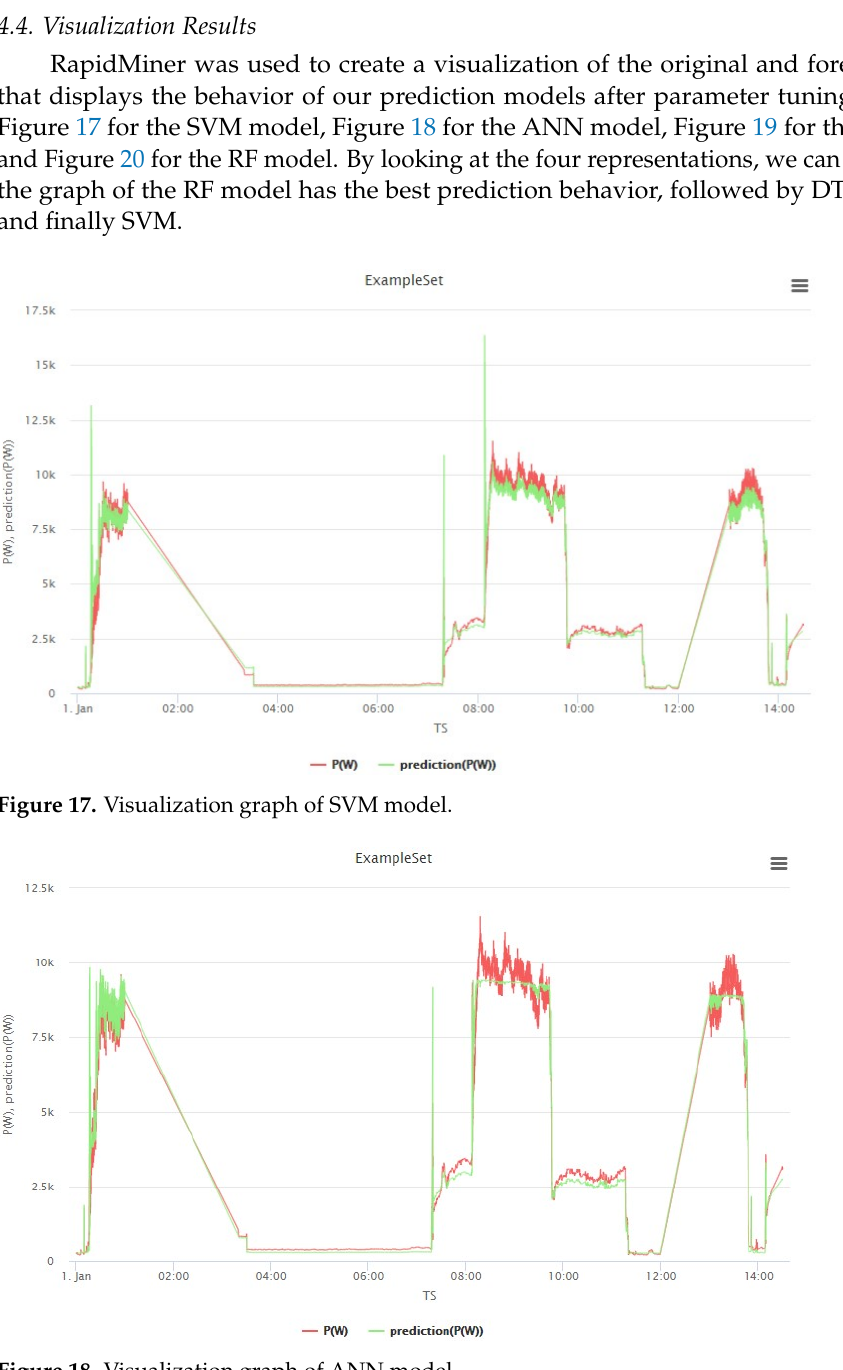
Figure 19. Visualization graph of DT model.